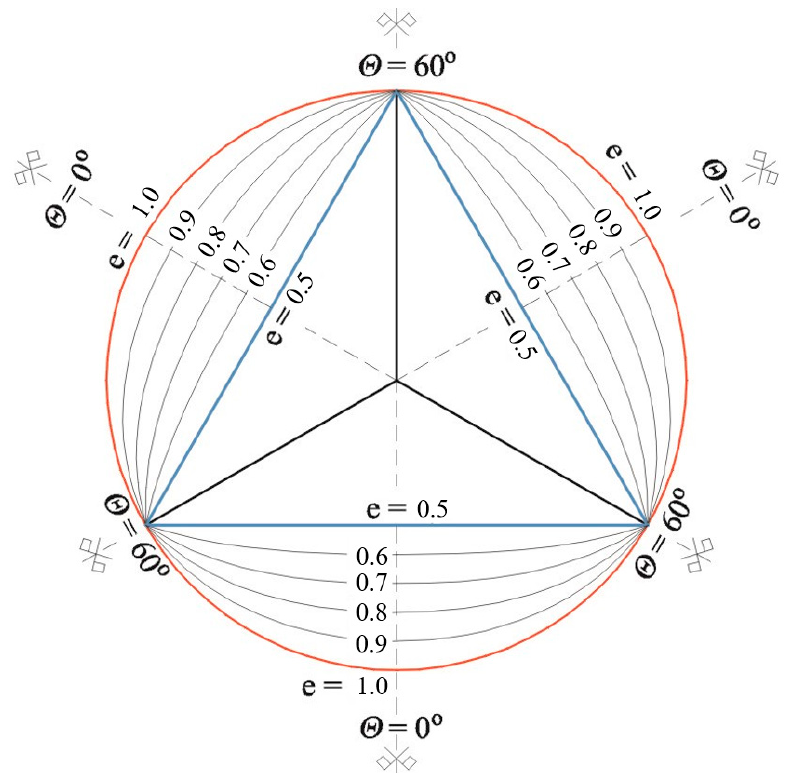
Figure 6. Elliptical curve shape 0.5 ≥ r ( Θ , e ) ≥